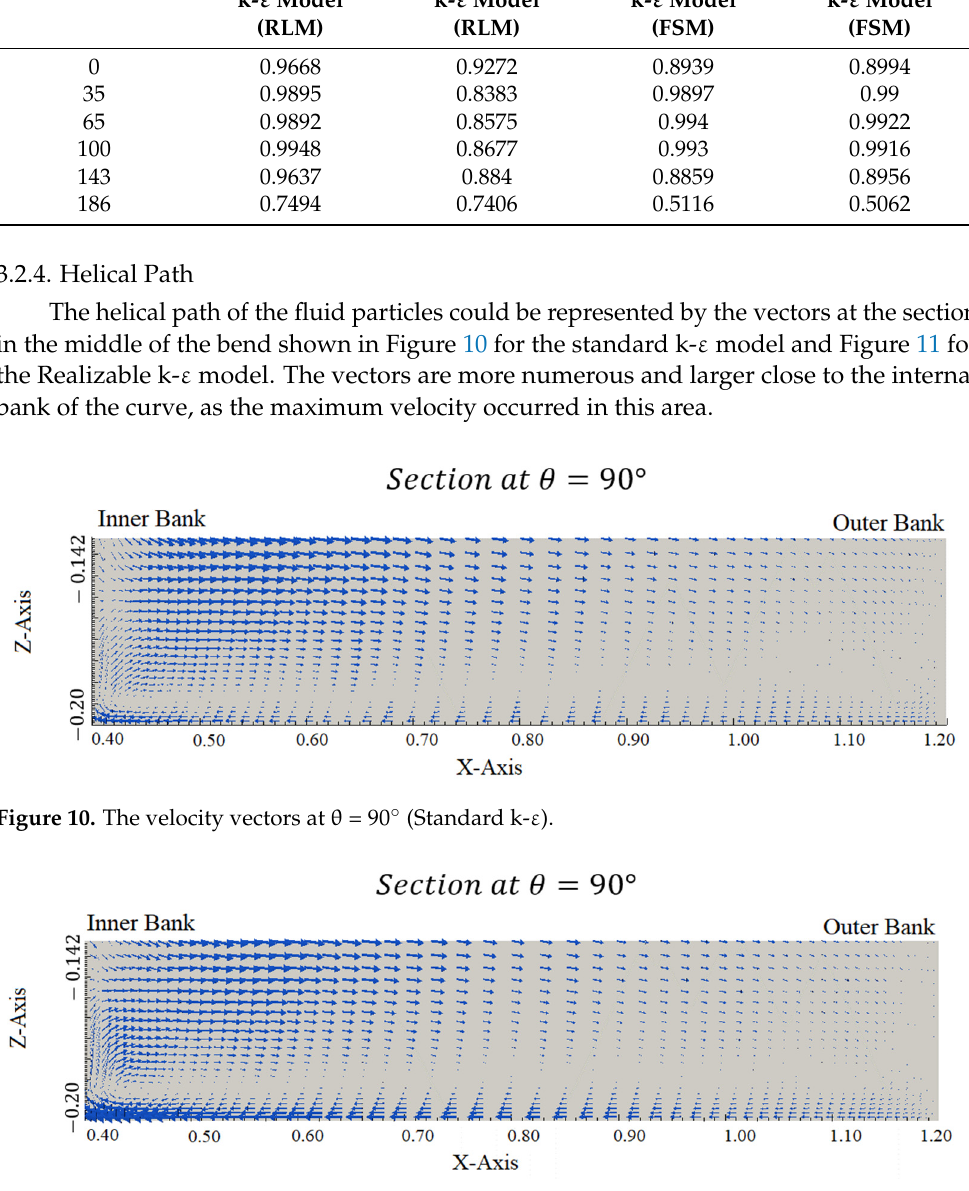
Figure 12. The confluent channel model (Shaheed et al., 2018) [14]. Table 4. The flow conditions and dimensions of the confluent channel (developed from Shumate) [23].